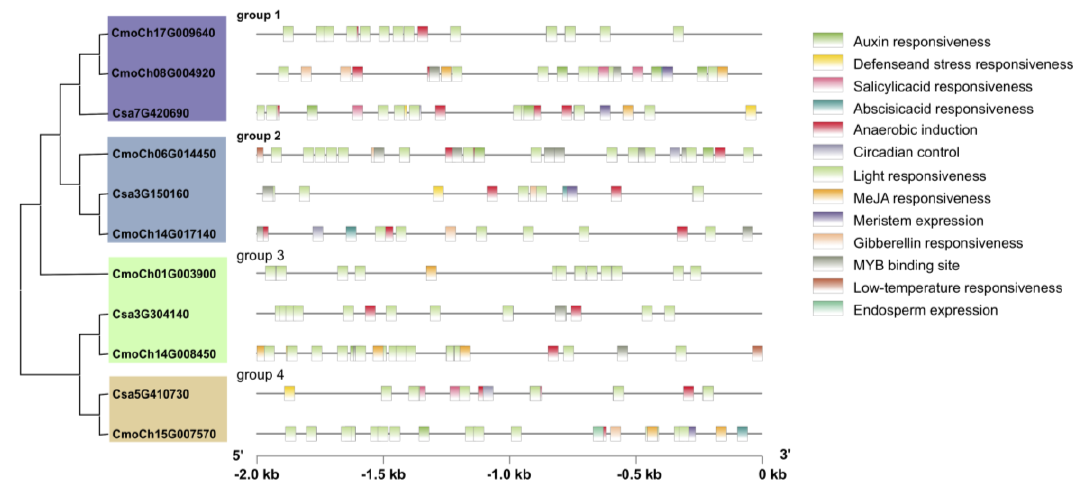
Figure 3. The regulatory regions of CmoGS and CsaGS gene members. This shows an area of 2000 bp upstream of ATG. ATG is at the position of “0” in the figure. GS gene members in different subfamilies are indicated by different colors on the left. The different color blocks on the right represent different regulatory elements and correspond to the color blocks on the line.